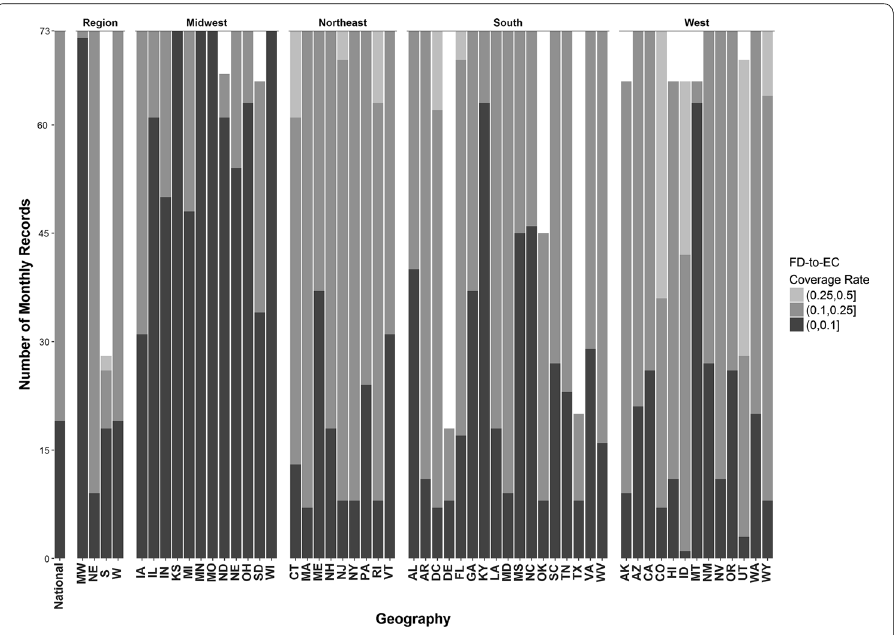
Fig. 1 First Data suppression rates and First Data-to-2012 Economic Census (FD-to-EC) coverage rates across months by geography for NAICS 447 (gasoline